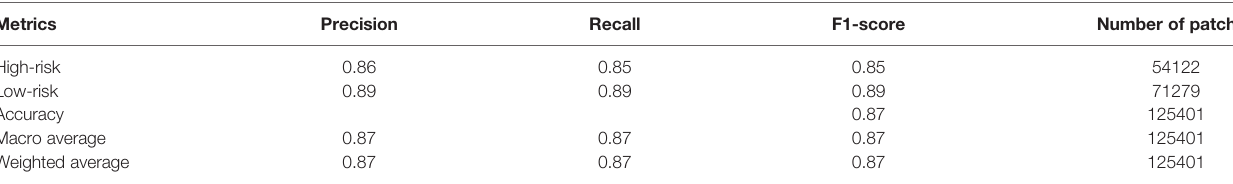
TABLE 2 | Model performance in the independent test set.